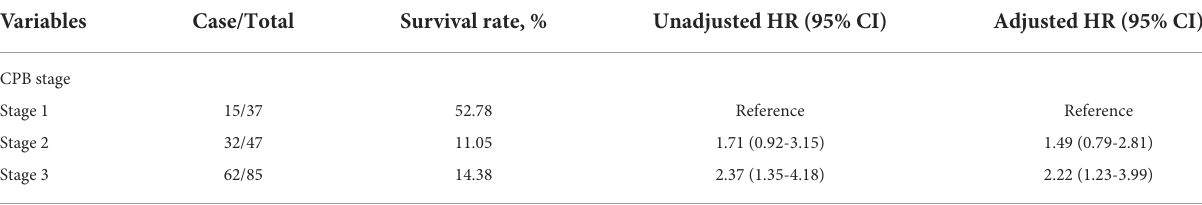
TABLE 4 Effect-size estimates for CPB stage in the derivation cohort.